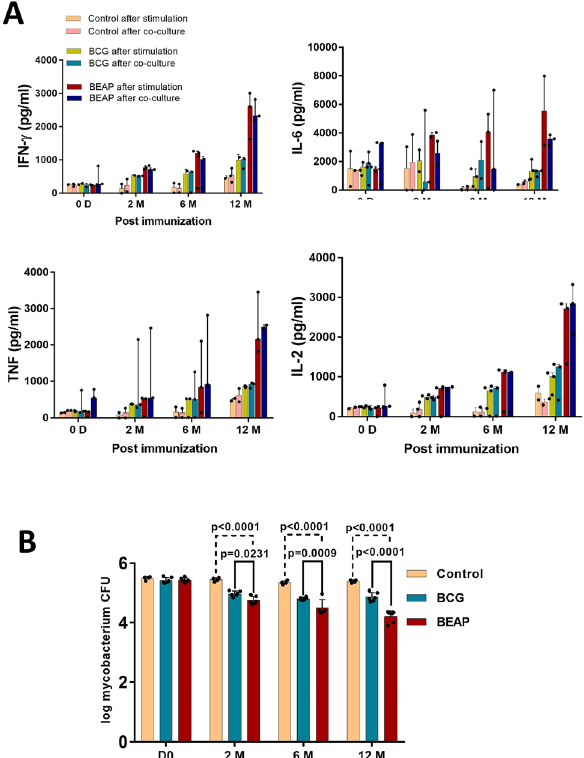
Figure 3. Efficacy and immune response elicited by BCG/BEAP. ( A ) The cytokine secretion profile in the supernatant of M.tb antigen stimulated T cells and when activated T cells were co-cultured with M.tb infected macrophages from the respective animals. Dots indicate data points and bars are median with 95% confidence interval. ( B ) Mycobacterium colony-forming units obtained after M.tb infected macrophages and activated T cells were co-cultured. The data demonstrate a substantial decrease in the mycobacterium CFU in the BEAP and BCG immunization compared to control animals. Dots indicate CFU counts calculated from multiple plates and bars are mean ± SD and analysis was done using two-way ANOVA with Tukey’s correction for multiple comparisons. Graphs were plotted using GraphPad Prism version-7 program (https ://www.graph